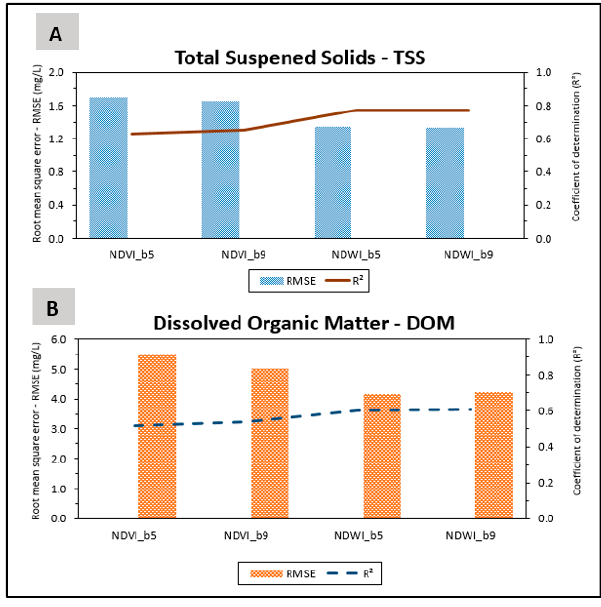
Figure 9. Comparison between the correlation results.